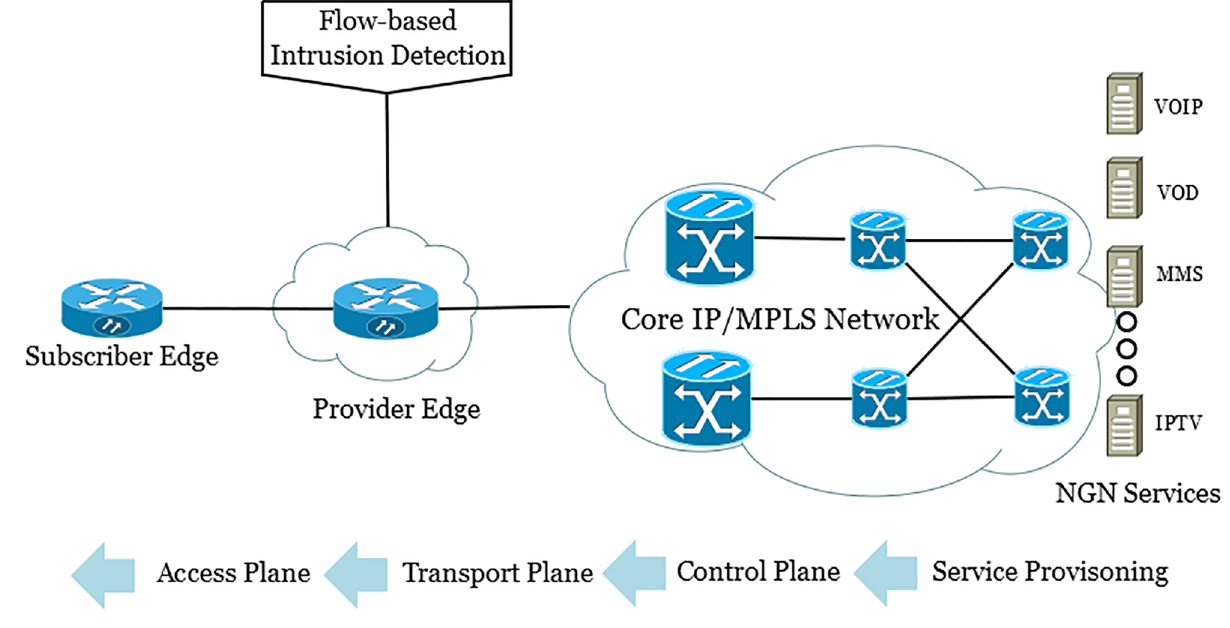
Fig 2. Flow monitoring in next-generation network architecture.